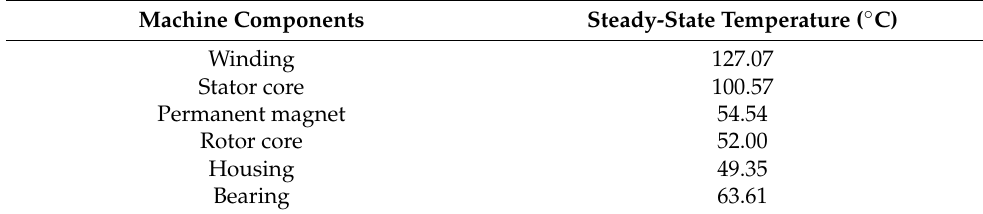
Figure 17. The transient temperature rise of the YASA machine.